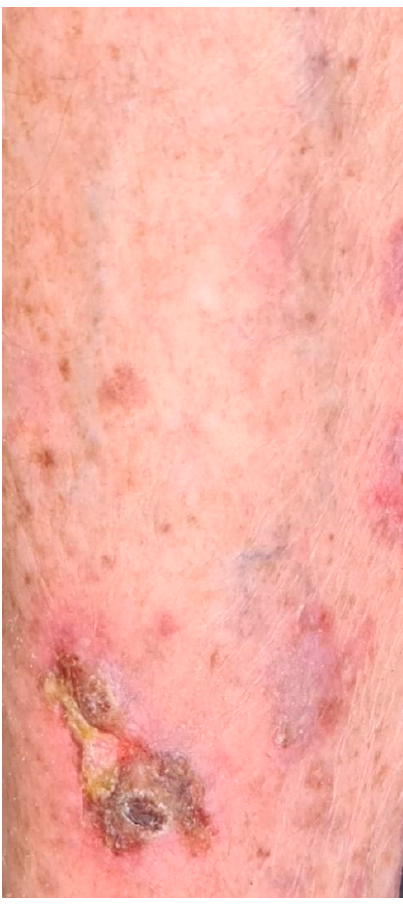
Figure 9. Leg erythema (Patient no. 6, Table 3).